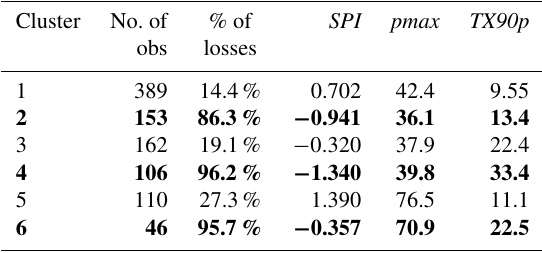
Table 4. Description for each identified cluster, with the SPI, pmax, and TX90p values used in the cluster analysis shown in italics. We specifically highlight clusters 1, 2, and 6 in bold, as these clusters were chosen for loss